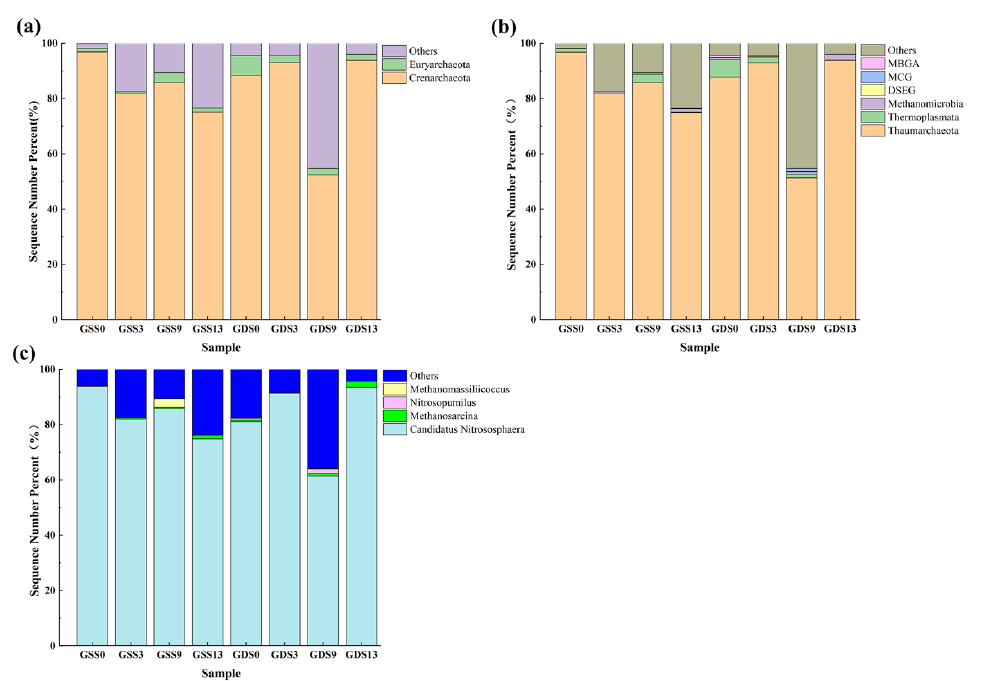
Figure 2. Dominant archaea in soil microbial communities at the phylum ( a ); class ( b ); genus ( c ) levels at different years of cultivation.